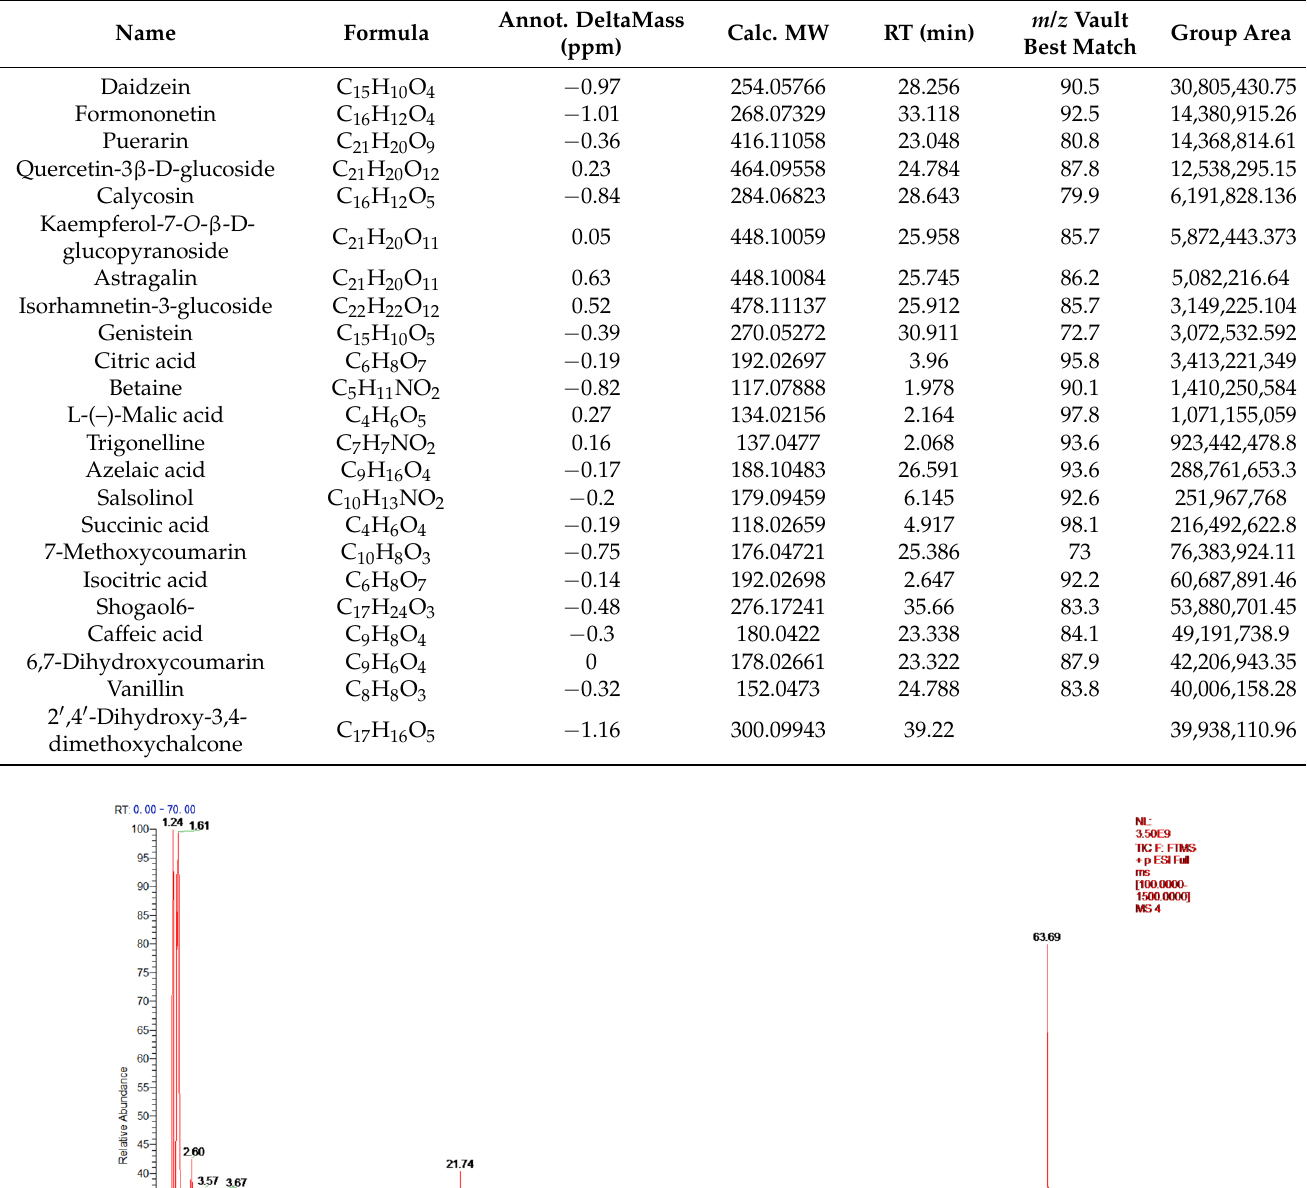
Table 3. Bioactive components of CHC-Herb identified with UPLC/MS.